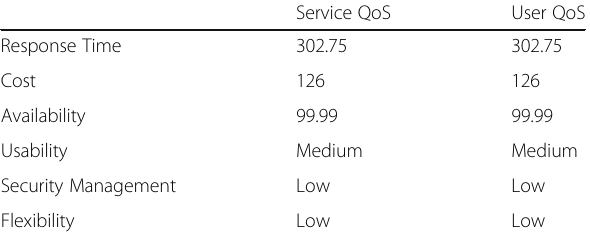
Table 3 Perfect Match of services and user